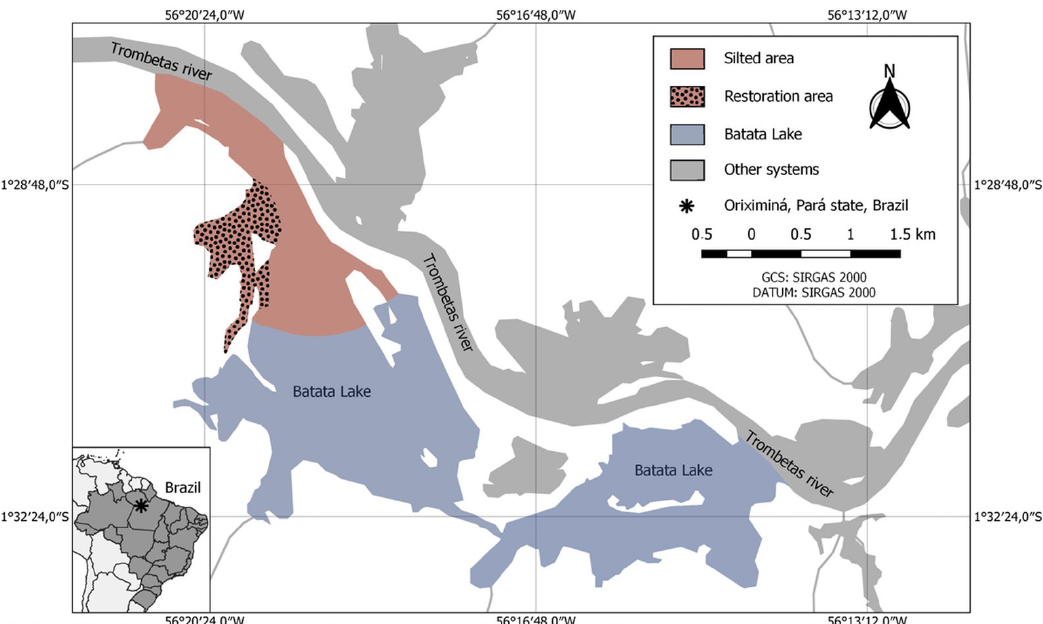
Figure 1. Map of the Lake Batata connected to the right bank of the Trombetas River. The impacted area, where bauxite tailing was discharged is shown in red. The limit of the igapó forest, where the restoration project is ongoing, is shown in the red dotted